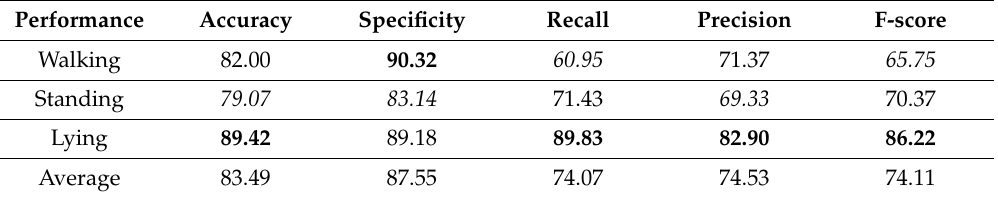
Table 1. Performance of o ffl ine KNN algorithm implementation when tested using previously collected data [8]. In italics is the lowest value and in bold is the highest value across the di ff erent behaviours.